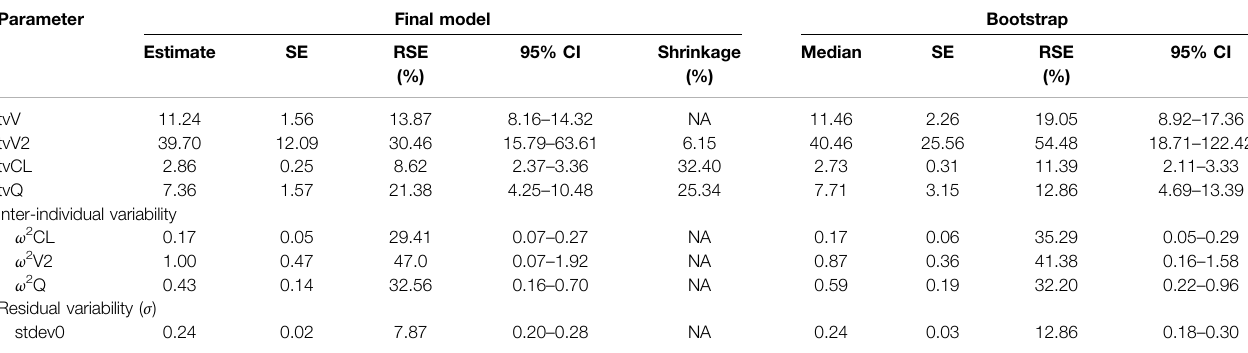
TABLE 2 | Parameter estimates of the fi nal population pharmacokinetic models. Parameter Final model Bootstrap